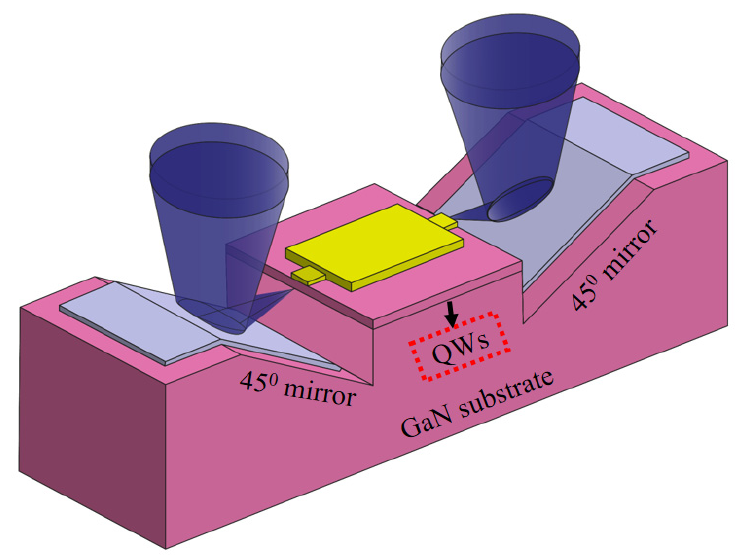
Figure 2. Cross sectional view of an individual emitter with the horizontal laser cavity adjoined with beam defecting 45° mirrors, whereas the red dotted lines indicate the position of the active region with Quantum Wells (QWs).